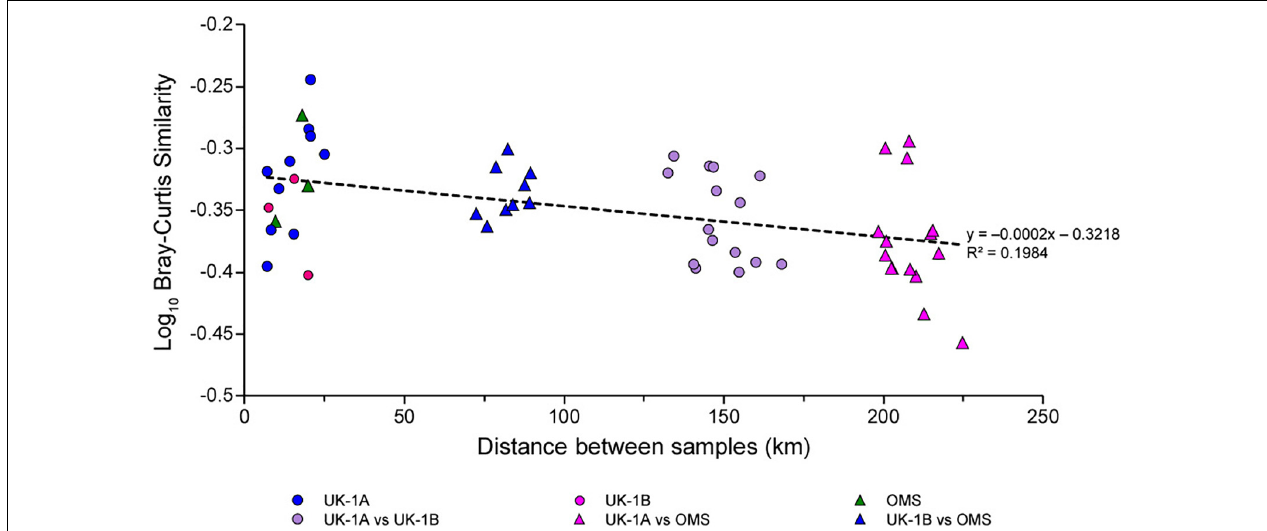
FIGURE 6 | Similarity between samples compared across increasing distances in the UK-1 and OMS contract areas. Based on Bray-Curtis similarity indices computed with species presence-absence data. The cluster of symbols at the left-hand side refers to comparisons of samples within each of the 30 × 30 km ‘strata’ (UK-1A, UK-1B, and OMS; 5, 3, and 3 samples, respectively); the other clusters refer to comparisons between these three strata. Similarity values within and between strata are significantly different ( t -test, p = 0.012) only when the two most widely spaced strata, UK-1A and OMS, are compared (cluster of purple triangles on right-hand side). However, the overall trend indicated by the dotted line is significant (Spearman’s rank correlation, rs = 0.373, p = 0.006). Redrawn from Deep-Sea Research I, vol. 149, A. Goineau and A.J. Gooday, Diversity and spatial patterns of foraminiferal assemblages in the eastern Clarion–Clipperton zone (abyssal eastern equatorial Pacific), Article 103036, 2019, with permission from